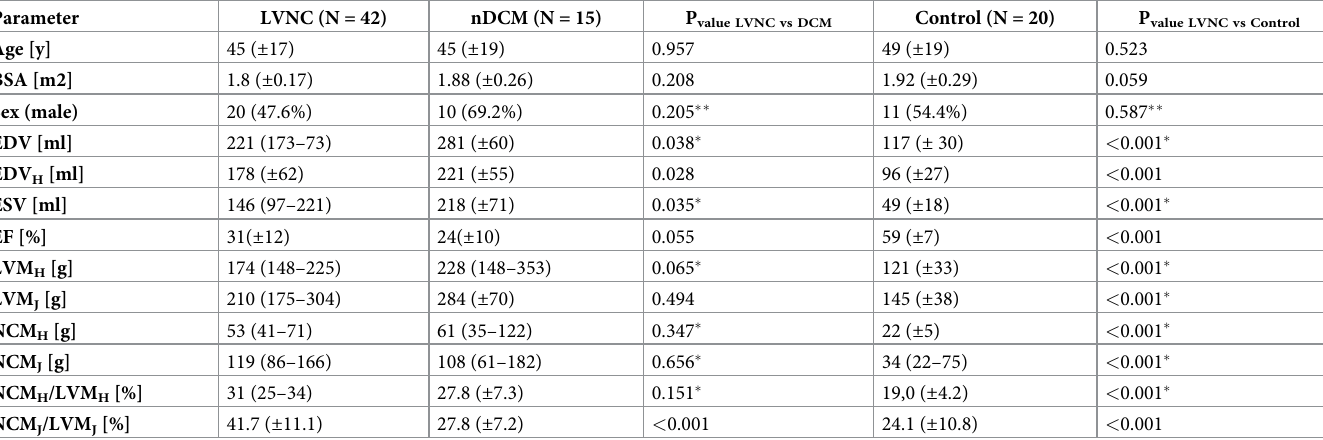
Data are presented as mean ± SD (CI ± 95%) and median with interquartile range (25–75%) values. BSA–body mass index (Du Bois), LV–left ventricular, EDV–LV